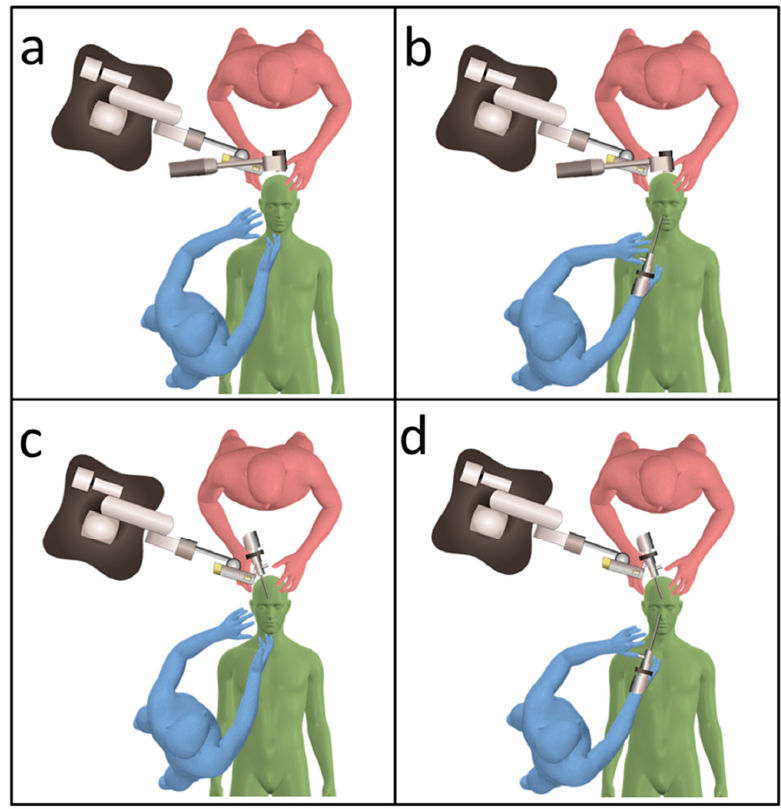
Figure 5. Schematic diagram of the two-surgeon set-up utilized in this case series. ( a ) Transcranial surgeon (red) using an exoscope and transfacial surgeon (blue) using no observation device. ( b ) Transcranial surgeon (red) using an exoscope and transnasal surgeon (blue) using an endoscope. ( c ) Transcranial surgeon (red) using an endoscope and transfacial surgeon using (blue) no observation device. ( d ) Transcranial surgeon (red) and transnasal surgeon (blue) both using endoscopes. For any combination, neither the exoscope nor endoscope interfered with the field of vision or procedures carried out by either surgeon. Green,